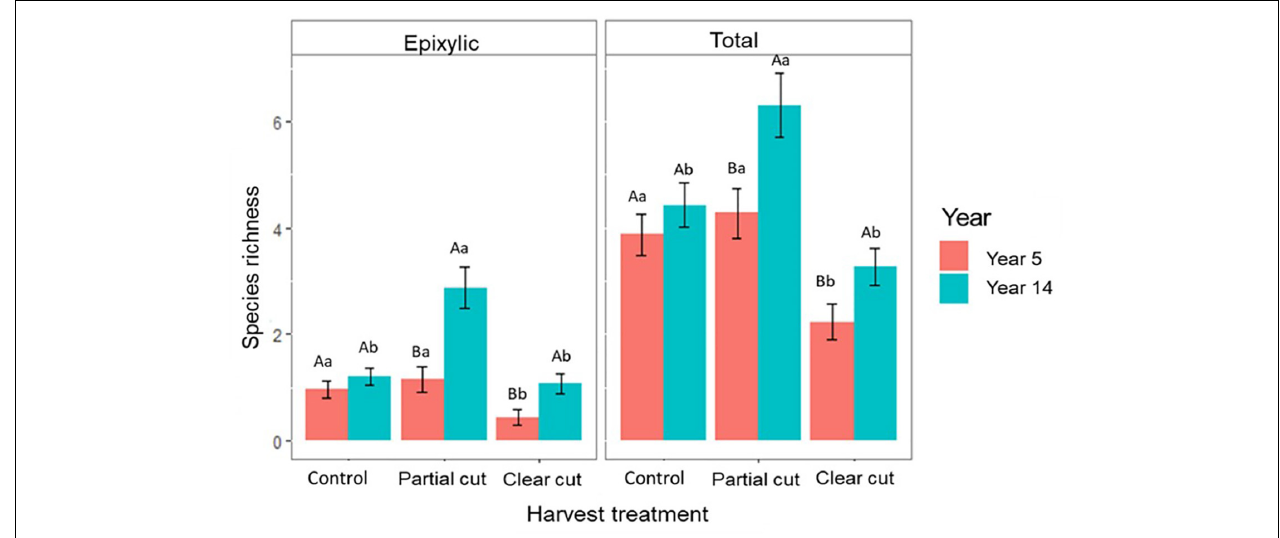
FIGURE 2 | Mean species richness per harvest treatment in years 5 and 14 ( n = 30 plots). Significant differences ( p ≤ 0.05) are indicated by different letters following the ranking (a > b > c). Different upper-case letters indicate significant differences between the same treatment of the two studies; different lower-case letters indicate significant differences between all treatments of the same